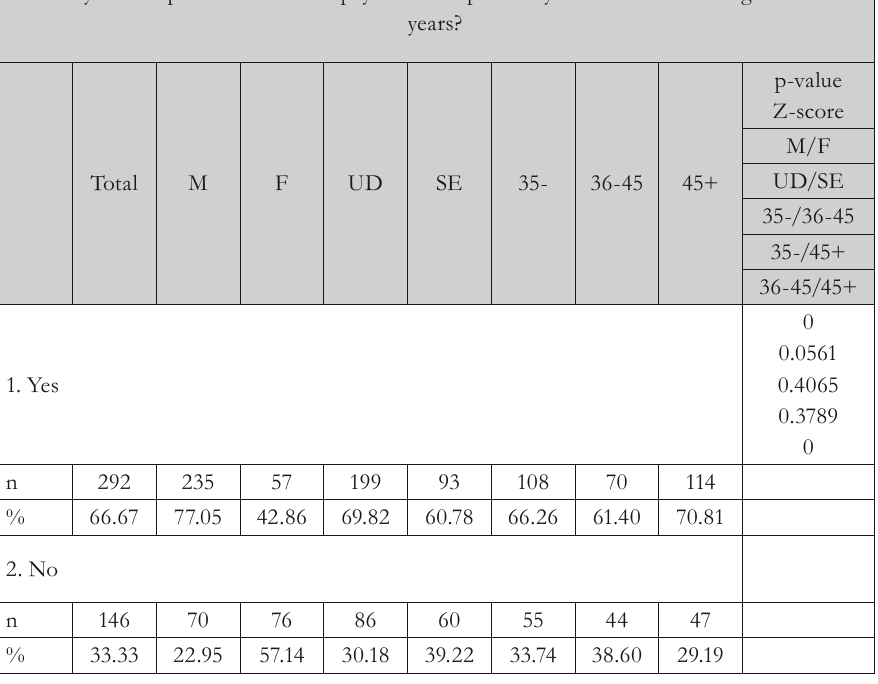
Tab. 1 – Problems with the payment disciplines of the clients. Source: own processing Have you had problems with the payment discipline of your customers during the last